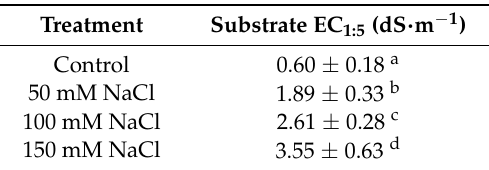
Table 1. Electric conductivity (EC 1:5 , dS · m − 1 ) of the substrates after 3 week treatments of the Phaseolus plants with the indicated NaCl concentrations. The values shown are means with SD ( n = 20). Different superscript letters indicate significant differences between substrates experiencing different treatments according to the Tukey test ( α = 0.05).